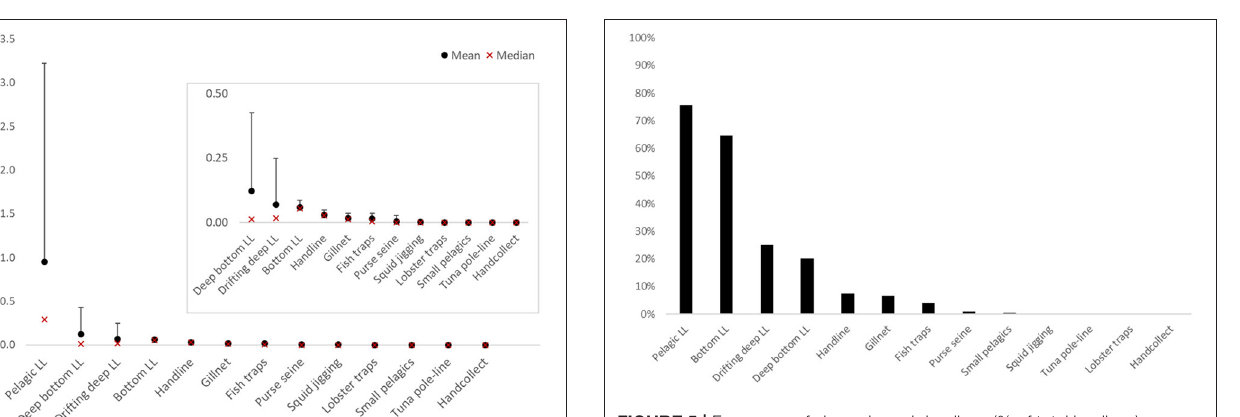
Endangered in the European Red List (Nieto et al.,